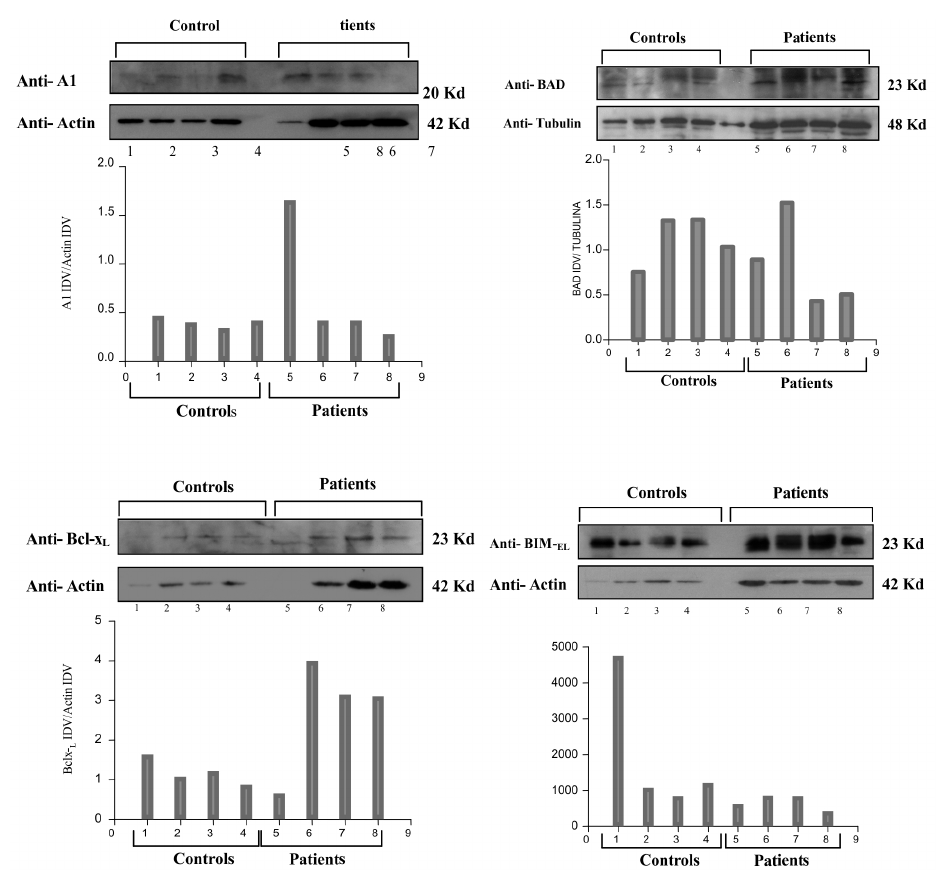
, Bad, and Bim- protein expression determined in peripheral leukocyte lysates from four PV patients FIGURE S1 - A1, Bcl-x L EL and four controls. A1, Bcl-x , Bad, and Bim- expression were assessed by immunoblot with specific antibody. Protein loading L EL is controlled by beta-actin or tubulin. Results were shown by blotting figures and protein expression quantification detected by densitometry and expressed by the ratio of target protein integrated density values (IDV) and beta-actin or tubulin IDV. Bcl-x A1 presented a high expression while Bad protein levels were decreased in PV patients in comparison with controls. Bim- levels are also reduced in PV patient leukocytes being only 35% of the values in normal individuals. TABLE S2 - Correlation between JAK2 V617F allele